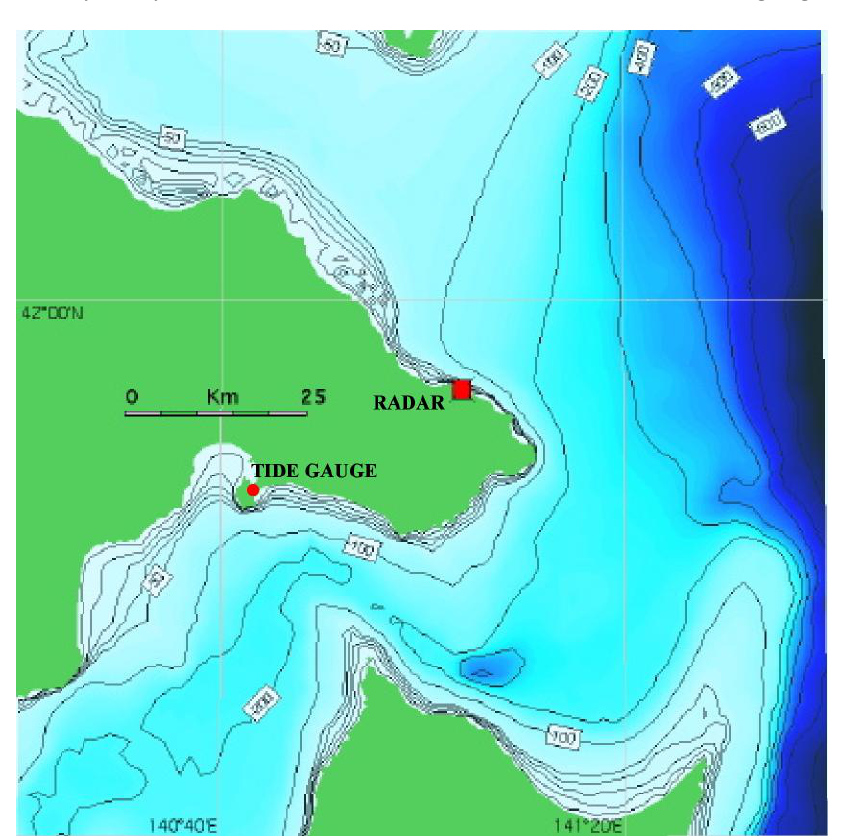
Figure 3. The bathymetry offshore from the radar at Kinaoshi and the tide gauge at